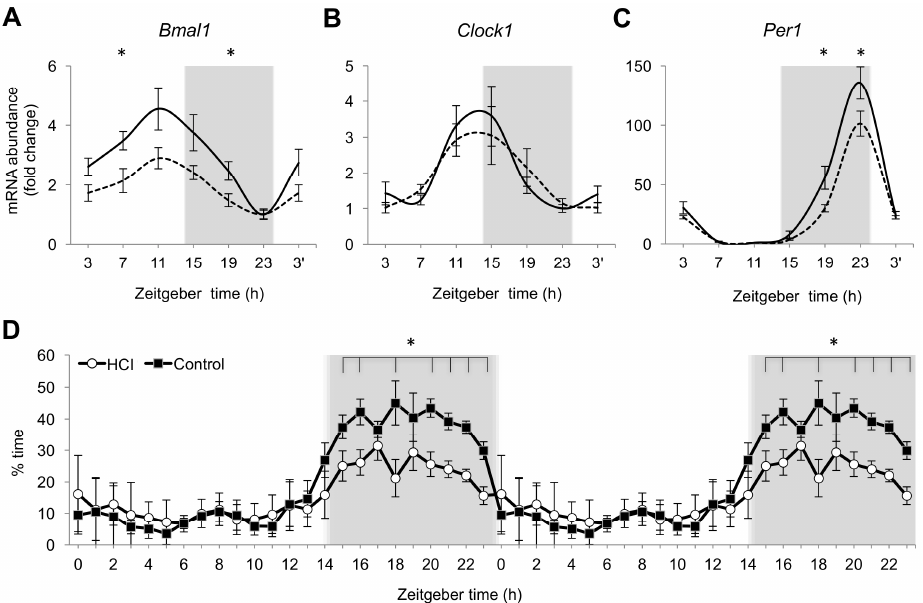
Figure 2. Reduction in nighttime sleep and expression of core clock genes in diet-induced premature aging. ( A – C ) Fold change in mRNA abundance over a 24-h period for the core clock genes ( Bmal1 , Clock1 , Per1 ) in 1-year old HCI and Control fish, relative to within-group minimal expression. n = 5–6 fish per time point, per group. Solid line—Control, dashed line—HCI. ( D ) Double-plot of percent time spent in sleep over a 24-h period. Black circle—Control, open circle—HCI. n = 8 fish per group. In ( A – D ): Mean ± SEM, * p < 0.05 1-year old HCI vs. 1-year old Control at specific time points. Grey background—night, 14:10 Light-dark (LD) cycle. Zeitgeber time (ZT) of sample collection, ZT0 = lights-on time.